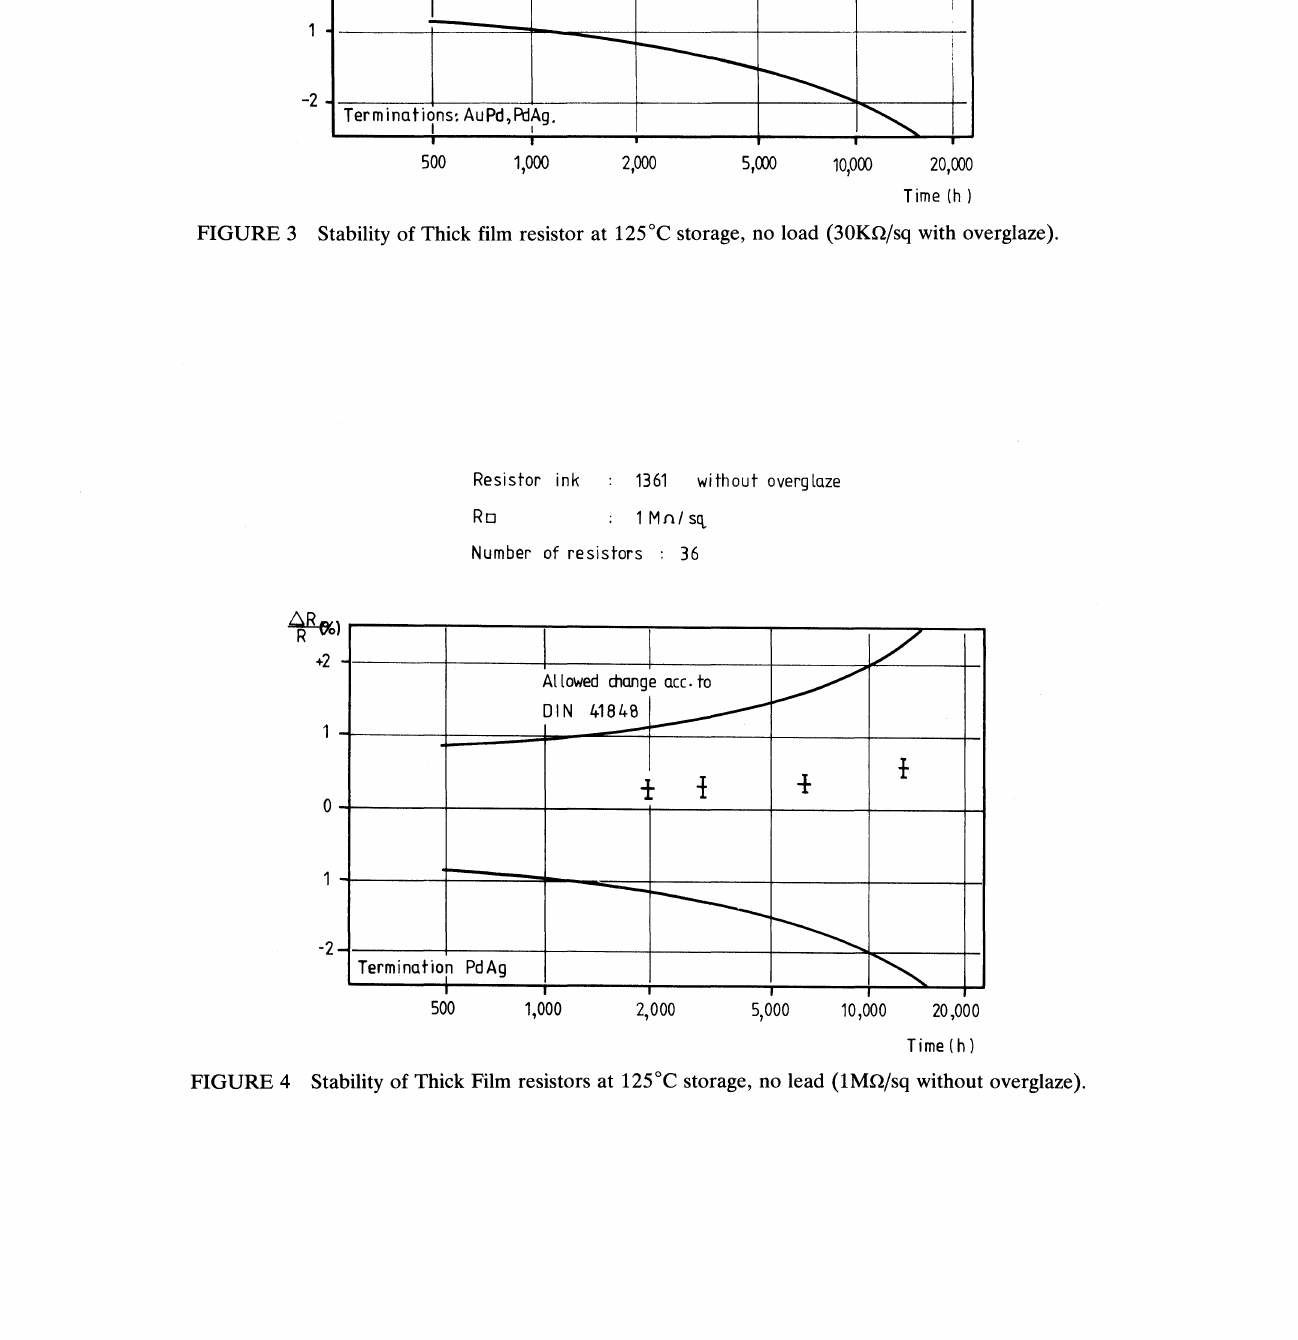
FIGURE 3 Stability of Thick film resistor at 125C storage, no load (30KD/sq with overglaze).